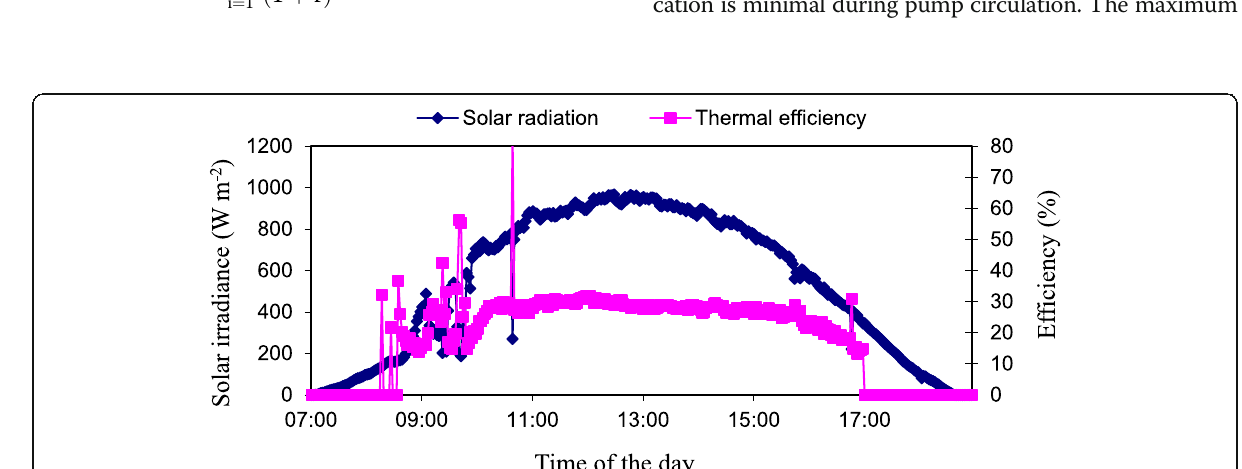
Fig. 6 Typical variation of thermal efficiency of Cluster 2 during a sunny